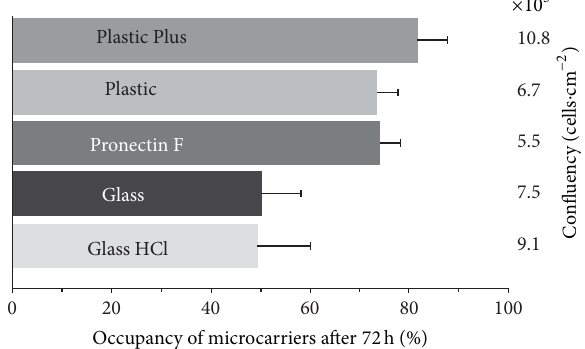
Figure 3: Occupancy and confluency of five different microcarriers after 72 h culture time in ultralow attachment 6-well plates with 0.0375 g of microcarriers in 1 mL DMEM LG medium at a seeding density of 8000 cells ⋅ cm −2 . Bars represent one standard deviation of threefold